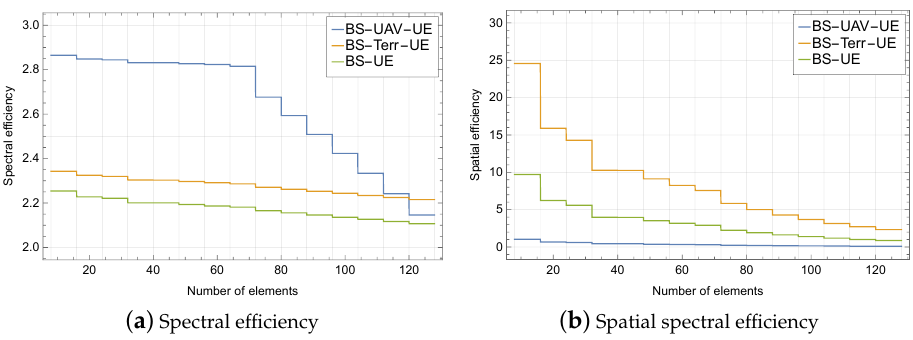
Figure 5. Spectral and spatial efficiencies of the considered deployment